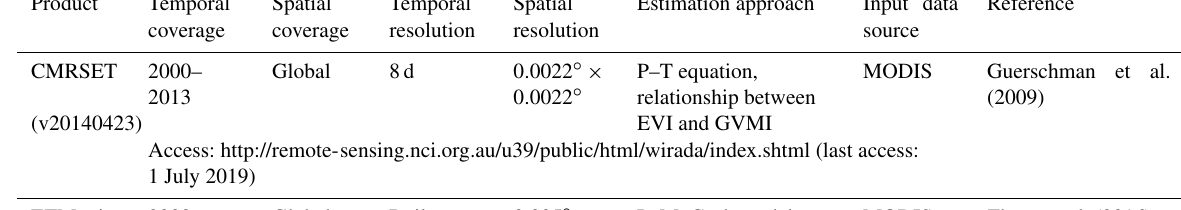
Table 2. Characteristics of remotely sensed ET products.